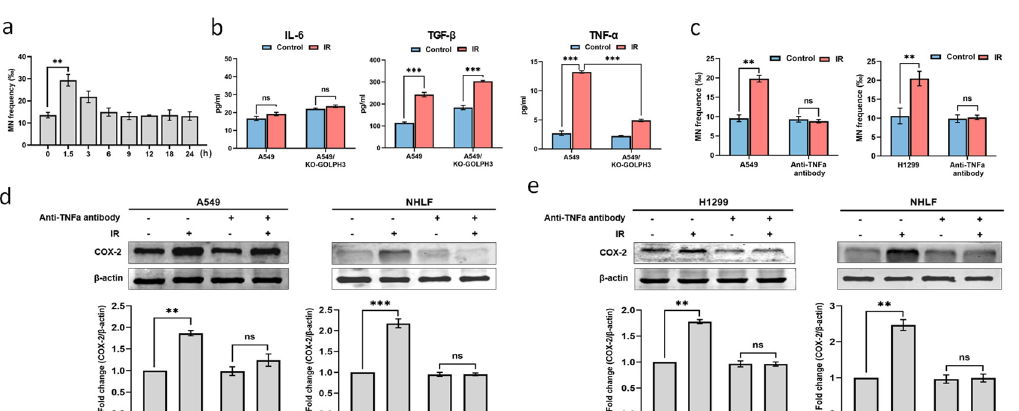
Figure 3. GOLPH3 modulates RIBE via TNF- α released from the irradiated cells. ( a ) MN yields in A549 cells after treatment with CM harvested at indicated timepoints post radiation; ( b ) ELISA detec- tion of TNF- α , TGF- β and IL-6 in 1.5 h CM harvested from the irradiated A549 or A549/GOLPH3-KO cells; ( c ) MN yields in the bystander cells (A549 or H1299) treated by 1.5 h CM harvested from the irradiated A549 or H1299 cells with or without anti-TNF- α antibody supplement; ( d ) representa- tive Western blot and corresponding quantification of COX-2 in the bystander A549 or NHLF cells treated with 1.5 h CM harvested from irradiated A549 cells with or without anti-TNF- α antibody supplement; ( e ) representative Western blot and corresponding quantification of COX-2 in by- stander H1299 or NHLF cells treated with 1.5 h CM harvested from the irradiated H1299 cells with or without anti-TNF- α antibody supplement. **: p < 0.01; ***: p < 0.001; ns: not significant.